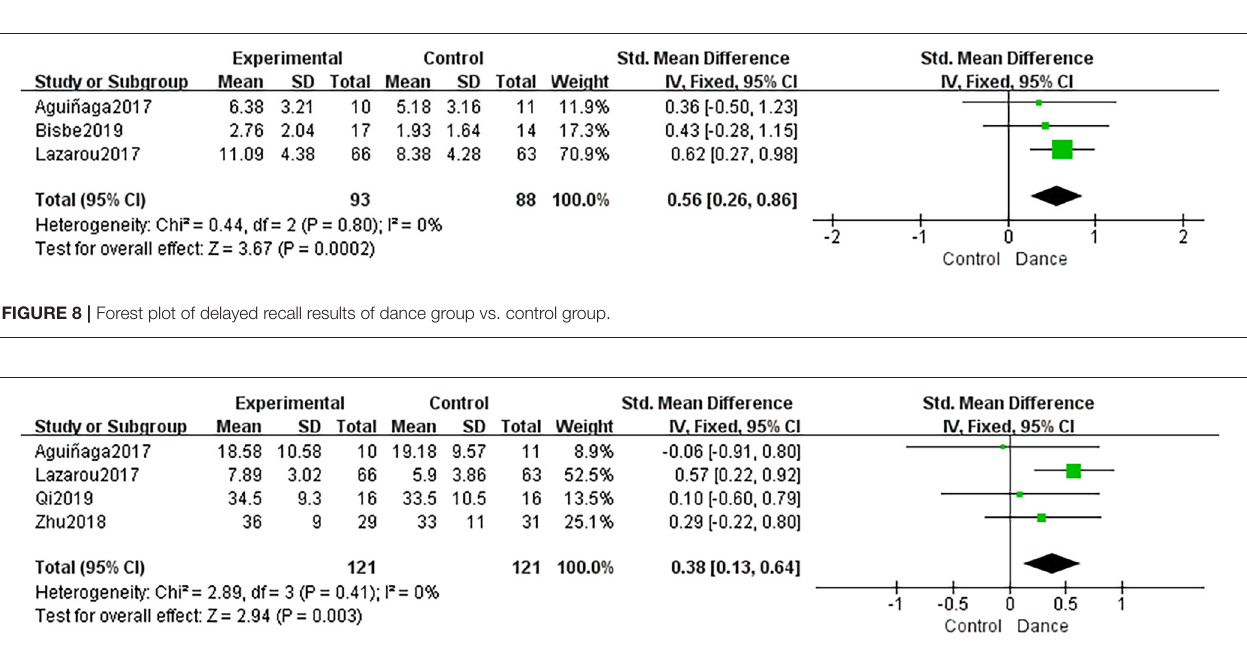
FIGURE 9 | Forest plot of attention results of dance group vs. control